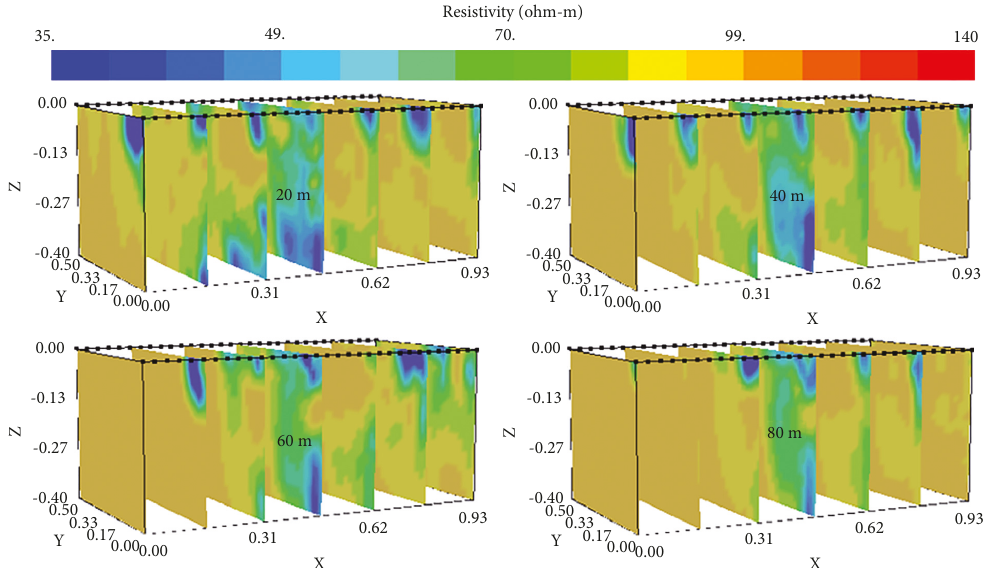
Figure 16: Three-dimensional resistivity inversion map of strata at 40cm above the coal